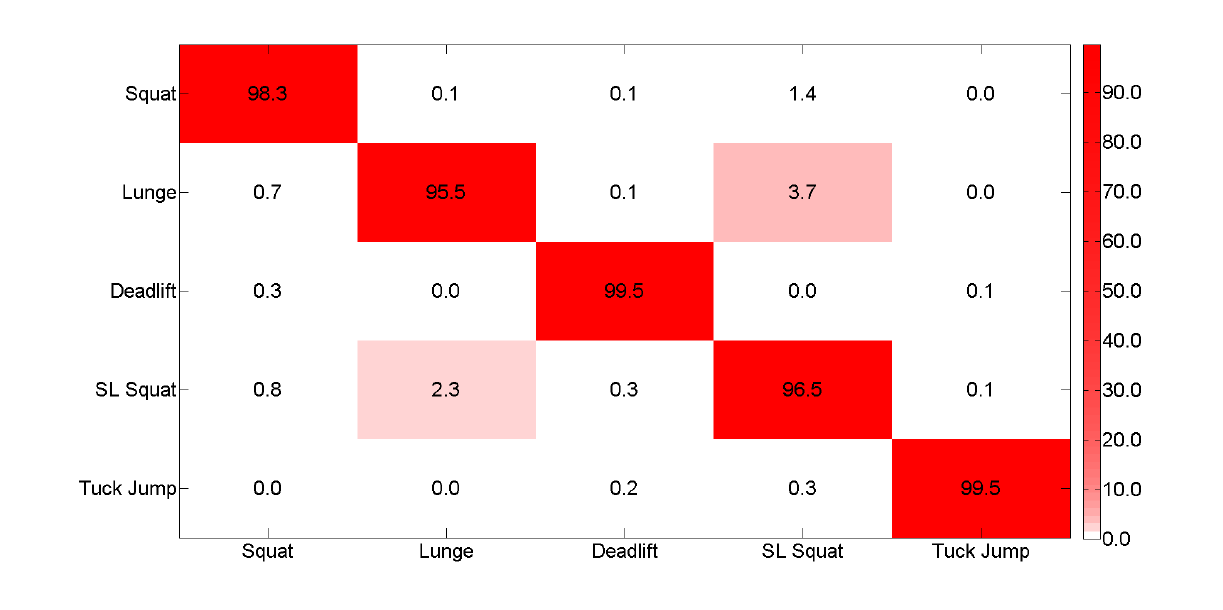
Figure 9. Confusion matrix for the machine vision-based classification method.